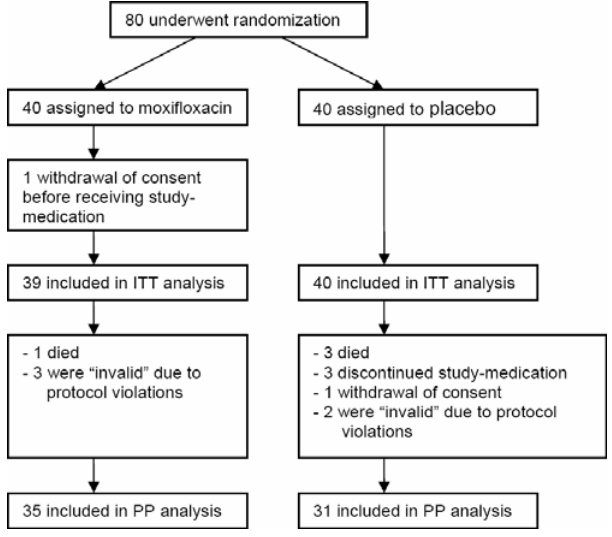
Figure 1. PANTHERIS trial profile.